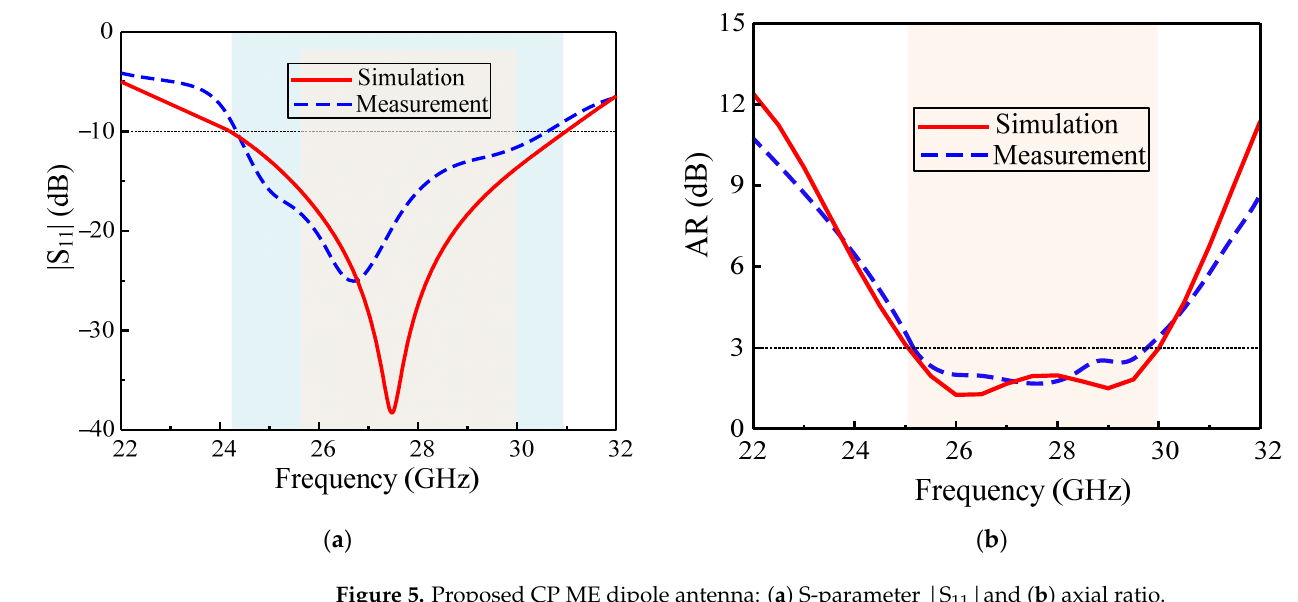
Figure 5. Proposed CP ME dipole antenna: ( a ) S-parameter |S 11 |and ( b ) axial ratio.